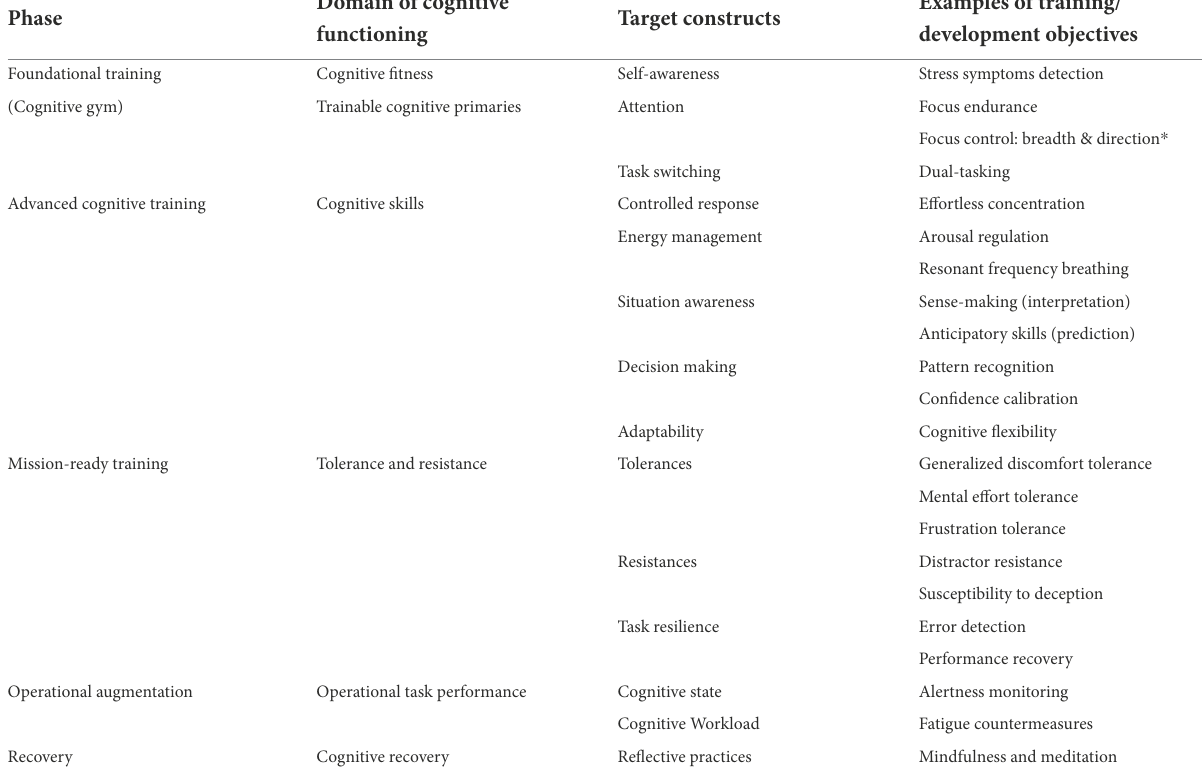
TABLE 2 Training targets in the Cog Gym 1.0 App: Modified from Aidman’s (2020) phases of the cognitive fitness